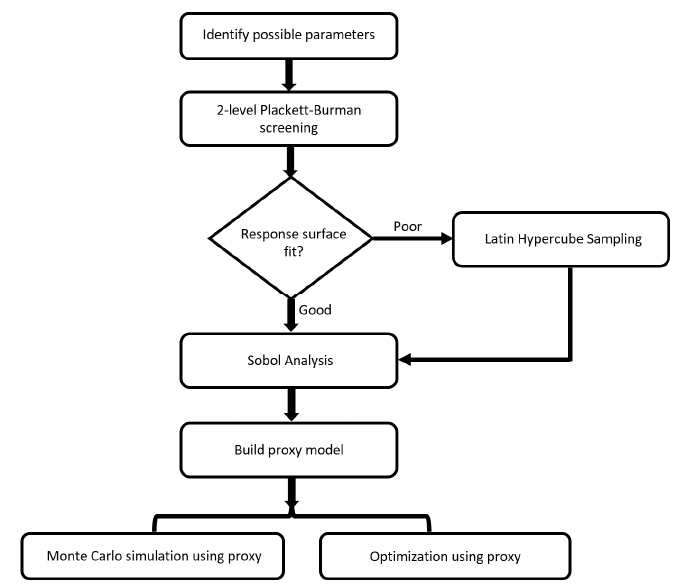
Energies 2021 , 14 , x FOR PEER REVIEW Figure 3. General DoE framework implemented in this study. Figure 3. General DoE framework implemented in this study.